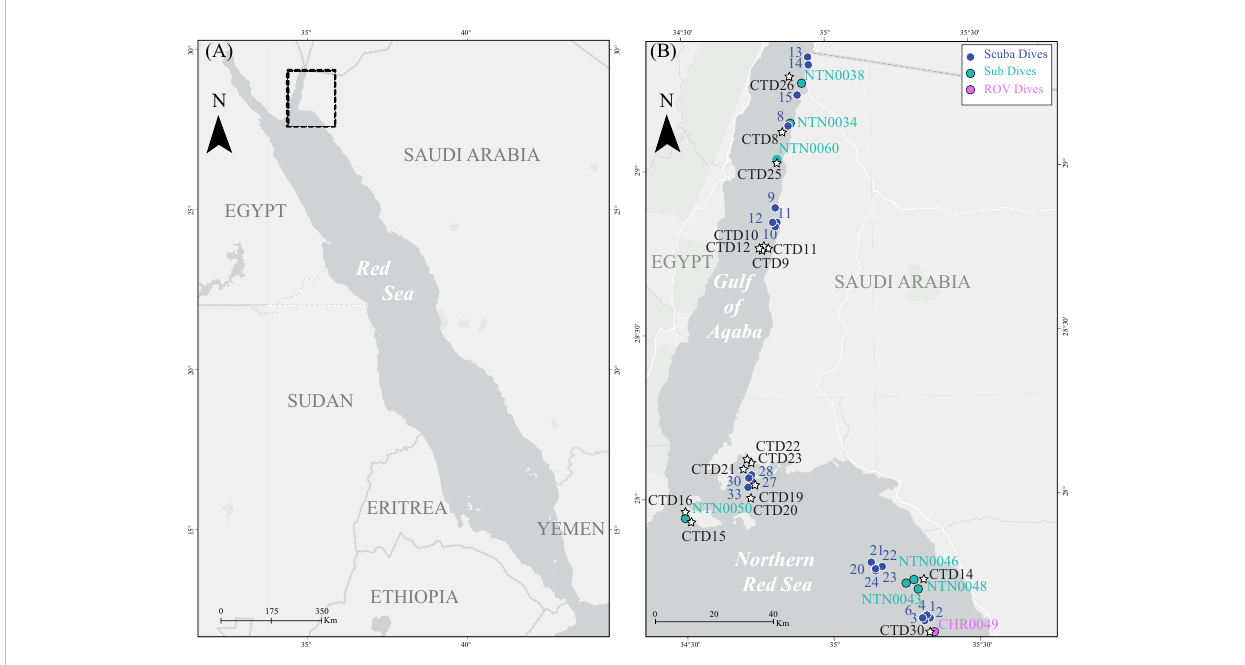
FIGURE 2 (A) Map of the Saudi Arabian Red Sea. (B) Close-up map showing sampling sites for the current study. Blue sequential numbers indicate scuba diving sites, light blue NTN codes indicate submarine sampling sites, and pink CHR codes indicate ROV sampling sites. Black CTD codes indicate CTD cast